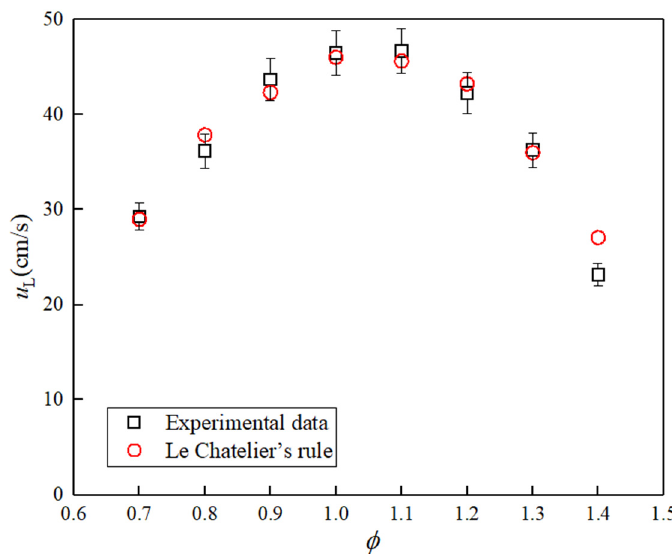
Figure 8. The comparison between estimated results calculated by Le Chatelier’s rule and experi- mental data of ETAC11.